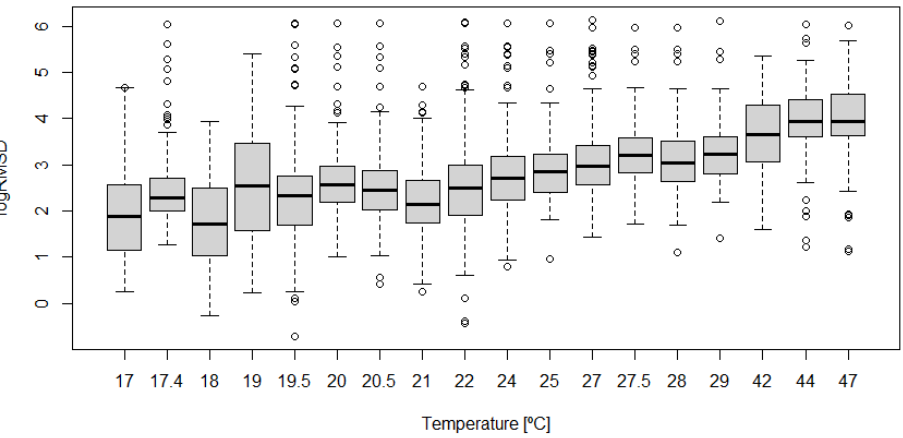
Figure 21. Boxplot for sensors of group 4.